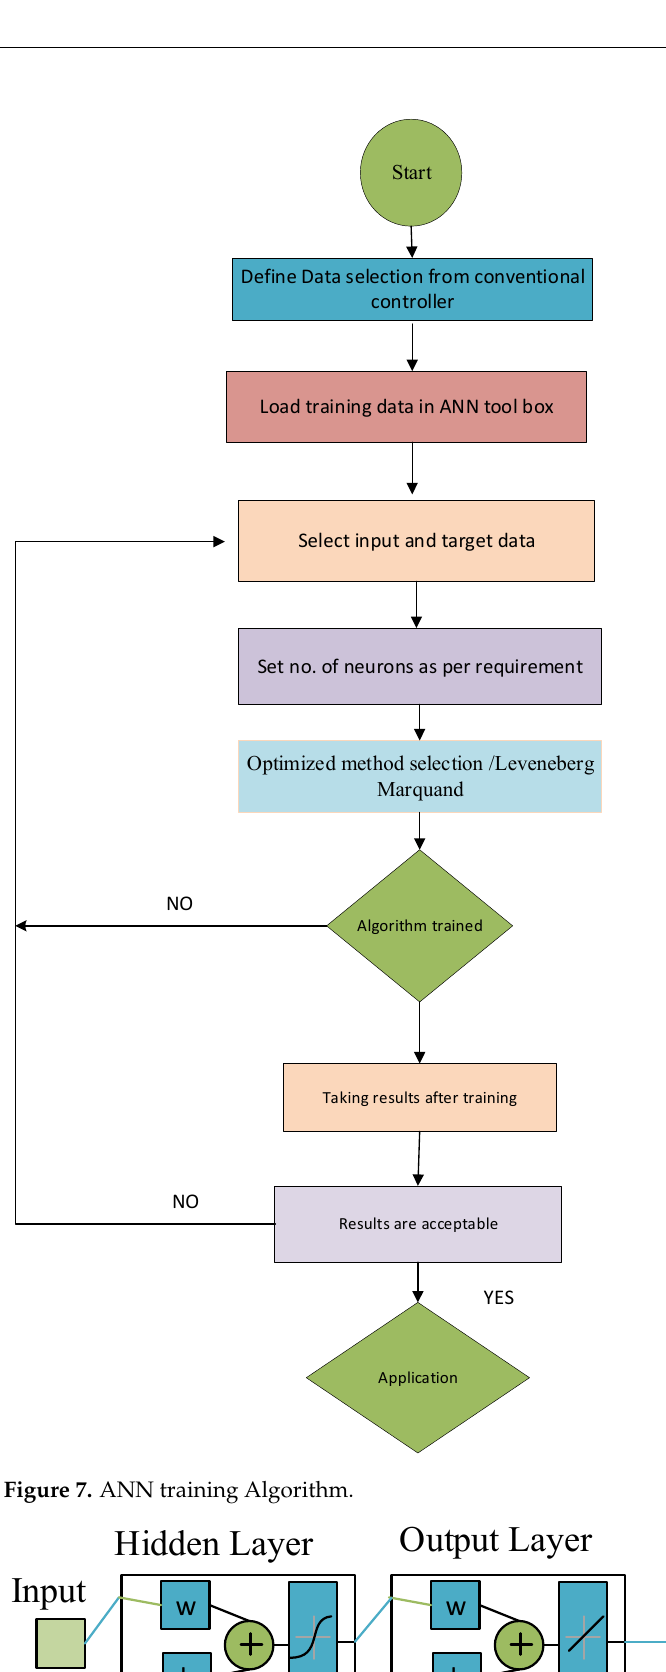
Figure 8. Capacitor Balancing ANN Structure.